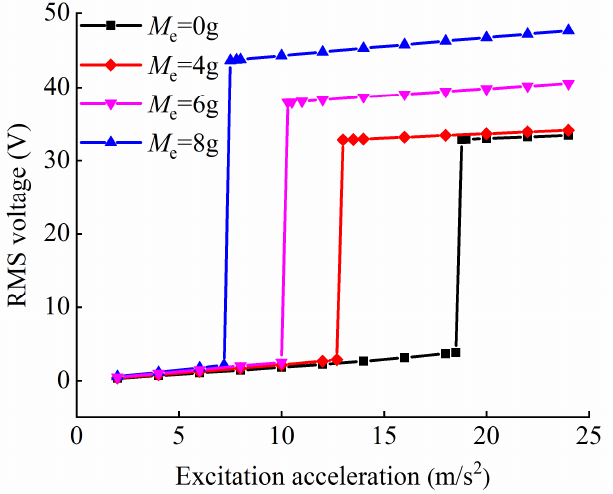
Figure 8. Excitation acceleration threshold of the system under different M e